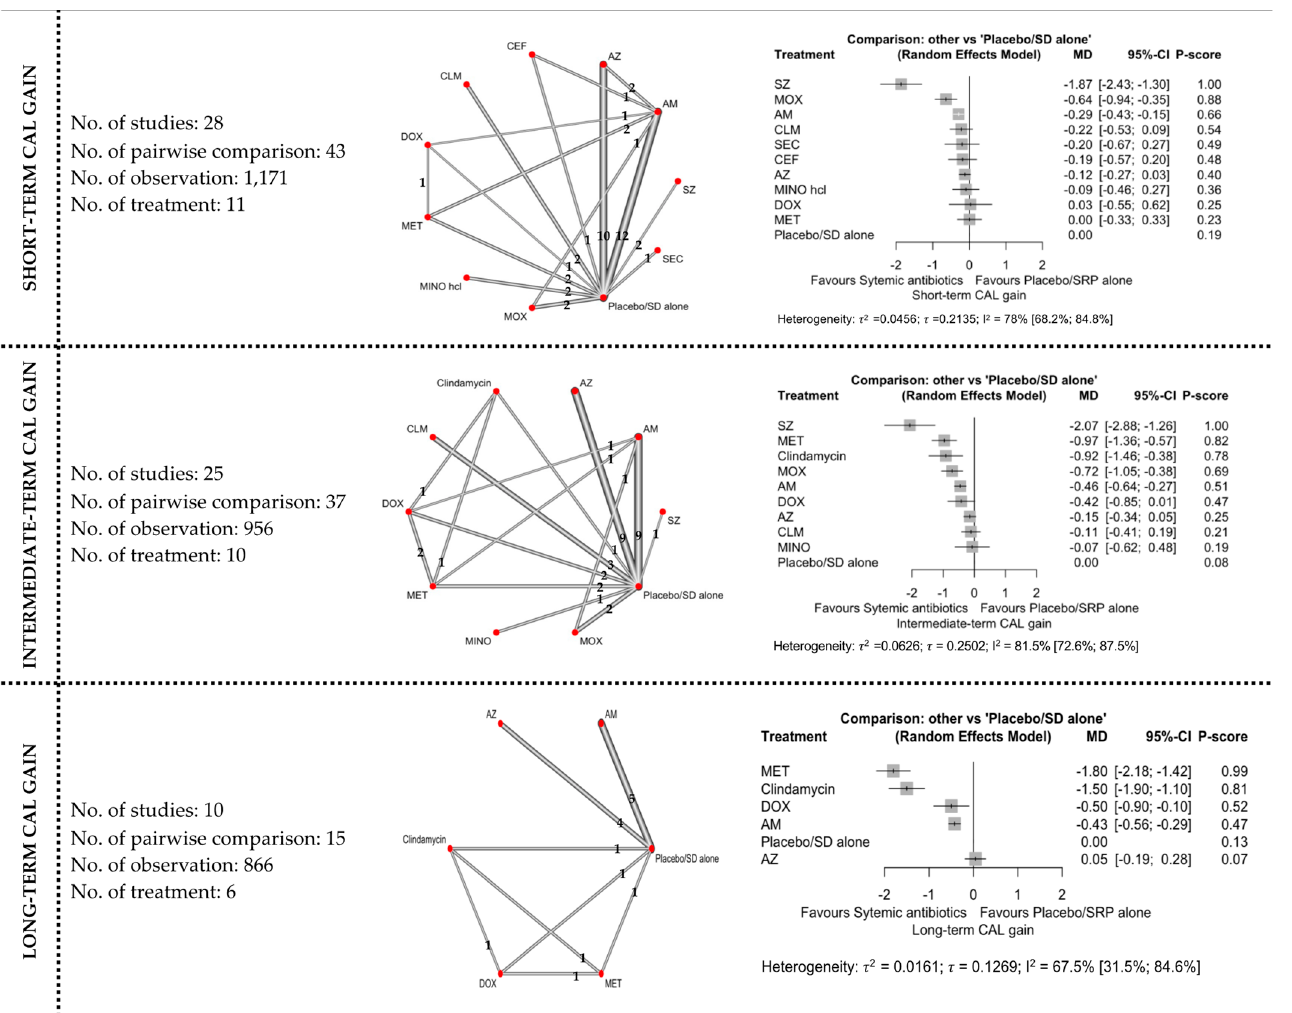
Figure 3. The network and forest plots of the network meta-analysis for CAL gain. AM: amoxycillin + metronidazole; AZ: azithromycin; CEF: cefixime; CLM: clarithromycin; DOX: doxycycline; MET: metronidazole; MINO: minocycline; MINO hcl: minocycline hydrochloride; MOX: moxifloxacin; SEC: secnidazole; SZ: satranidazole; SD: subgingival debridement.